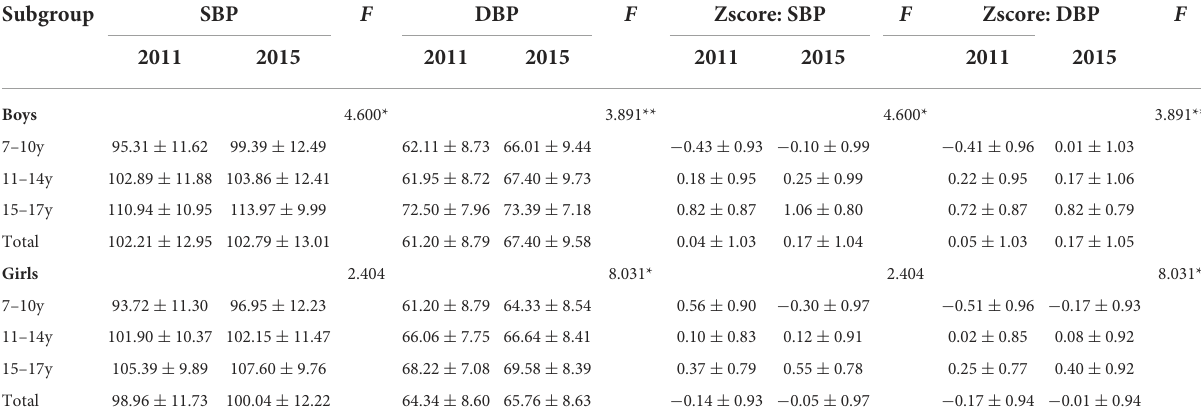
TABLE 2 The characteristics of blood pressure among different age and gender, 2011–2015.